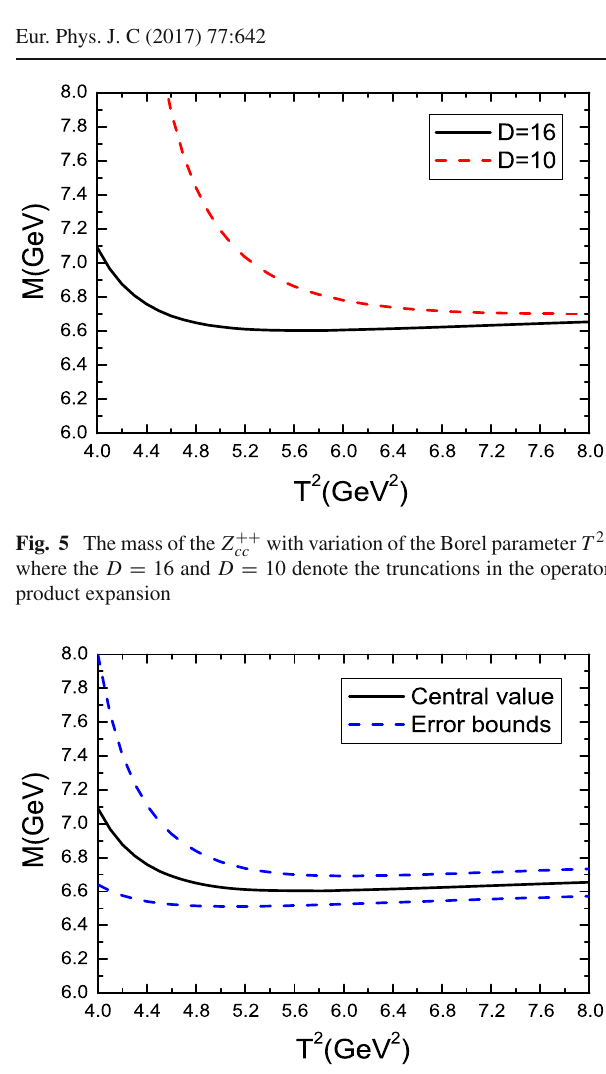
Fig. 6 The mass of the Z ++ cc with variation of the Borel parameter T 2